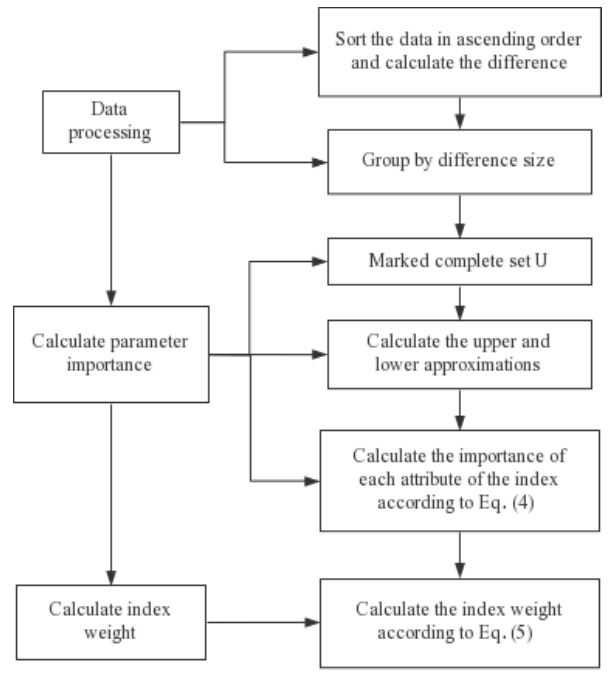
Figure 2. Flow chart of the objective weight calculation algorithm according to parameter